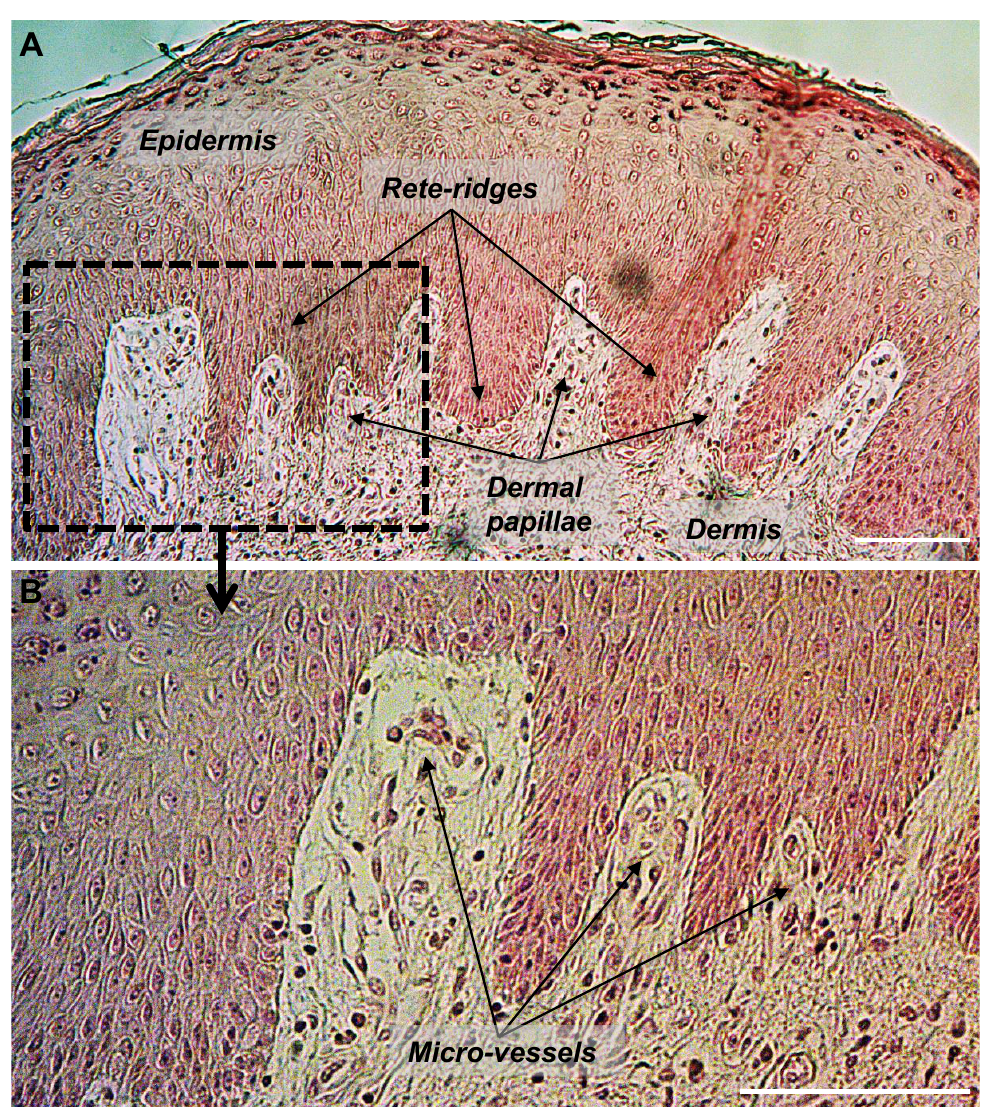
Figure 1. Histological section of human skin showing the undulated structure of the dermal-epidermal junction with epidermal rete-ridges and dermal papillae. Section of a paraffin-embedded skin biopsy from the abdomen of a 30 years old donor was processed for HES staining. ( A ) Epidermis, dermis, rete-ridges, and dermal papillae are shown. ( B ) Micro-vessels are shown within dermal papillae. Scale bars = 100 μm.